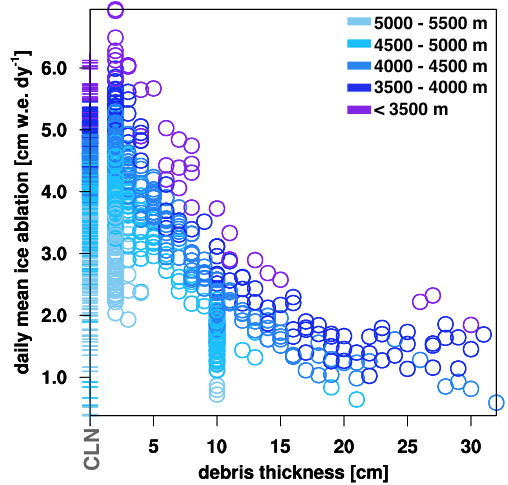
Figure 7. Daily mean ablation rate versus debris thickness for DEB (circle markers) and CLN (horizontal line markers), with the range of topographic height value of each data point indicated by the color of the marker. Here, “ablation” refers to sub-debris ice melt in DEB (i.e., only snow-free pixels are selected) and total column melt (sur- face and englacial) in CLN for the same pixels and time periods. The concentration of data points at 10cm thickness results from the specification of debris where centerline information was unavail- able (cf. Sect.